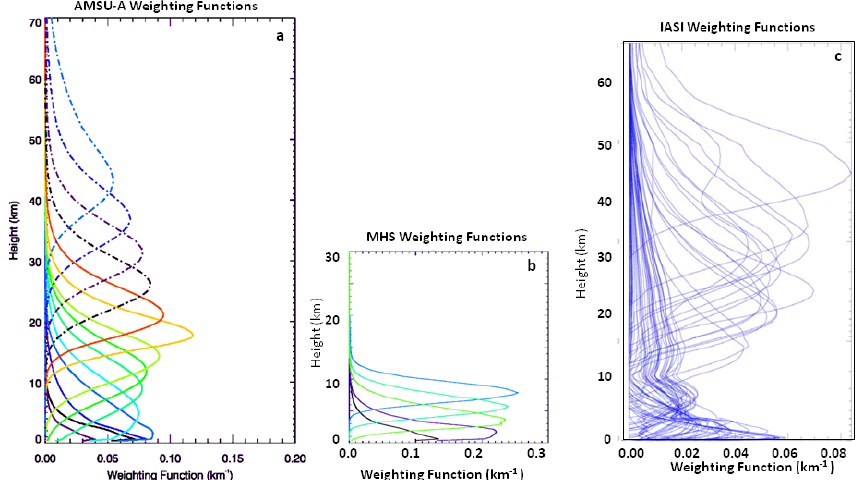
Figure 2. Vertical weighting functions for satellite observations as a function of height. (a) AMSUA , (b) MHS , (c) IASI.